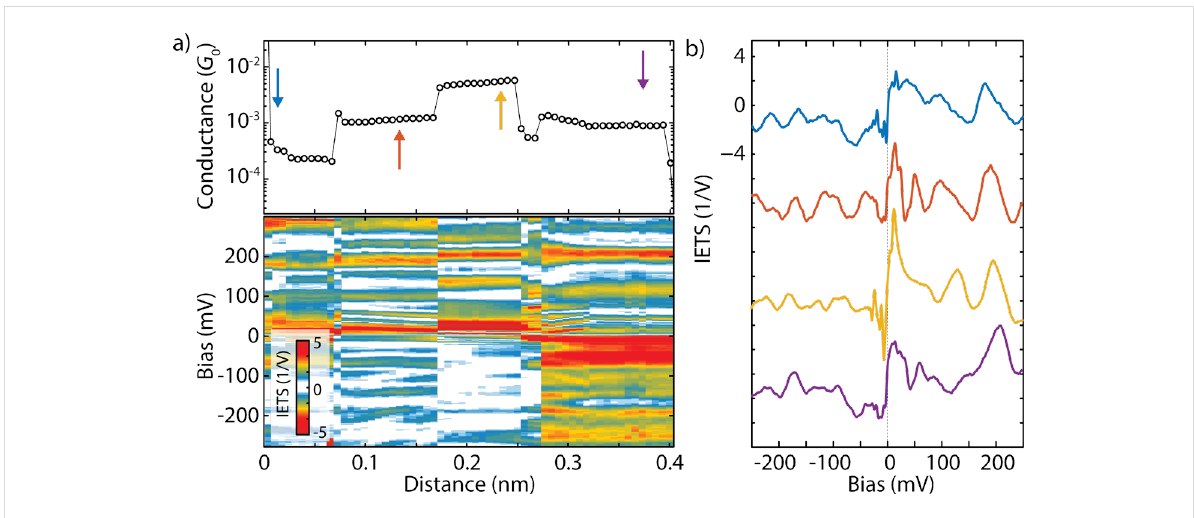
Figure 4: (a) Low-bias conductance trace recorded during the stretching of an OPE3 single-molecule junction (top) and color-map representing the IETS signal upon stretching (bottom). (b) Extracted IETS master-curves at the positions indicated by the arrows in (a). Note that not all peaks/steps are visible in the color-map for this choice of